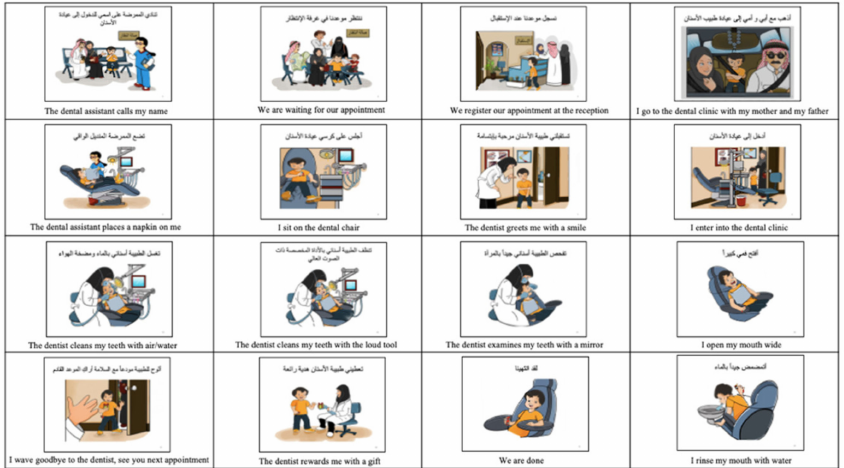
Figure 1. The culturally adapted dental visual aids: visiting the